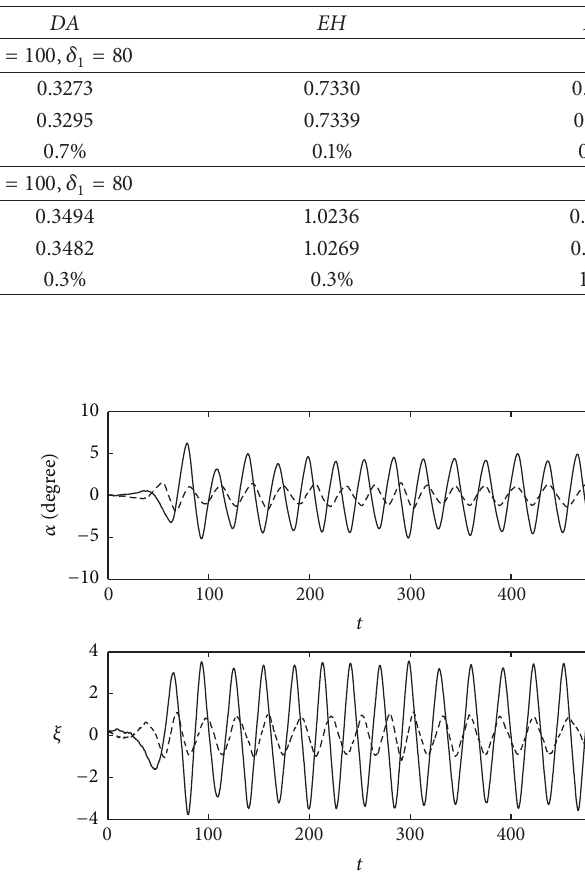
Figure 7: Time histories for system (8) with IC = [1 ∘ ,0,0,0] . Parameters are 𝑈/𝑈 𝑓 = 1.5 and 𝜂 = 8 (solid lines) or 𝜂 = 100 (dashed